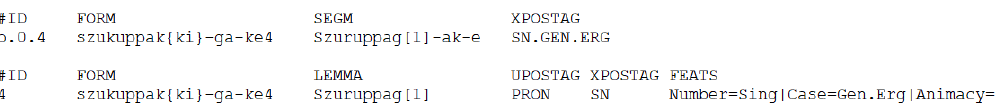
Figure 2. CDLI-CoNLL annotation compared to CoNLL-U, excluding syntax annotation (which is identical).